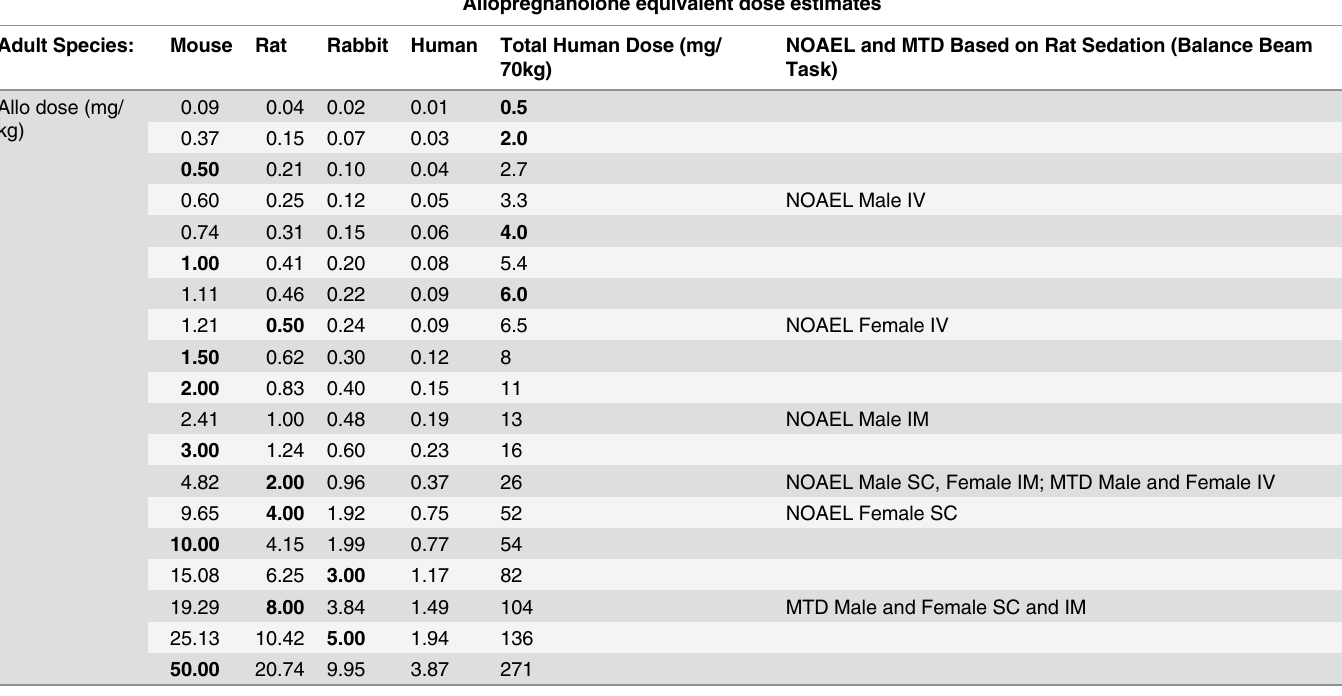
Table 4. Allopregnanolone equivalent doses in mouse, rat, rabbit, and human. Allopregnanolone equivalent dose